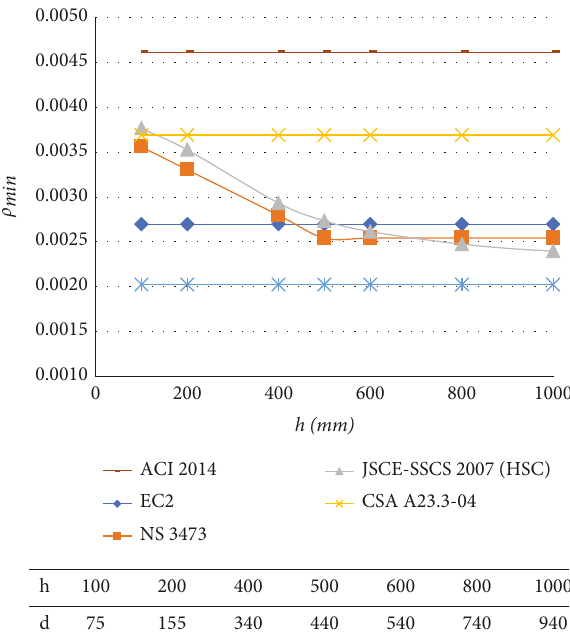
Figure 1: Comparison of the minimum reinforcement ratio